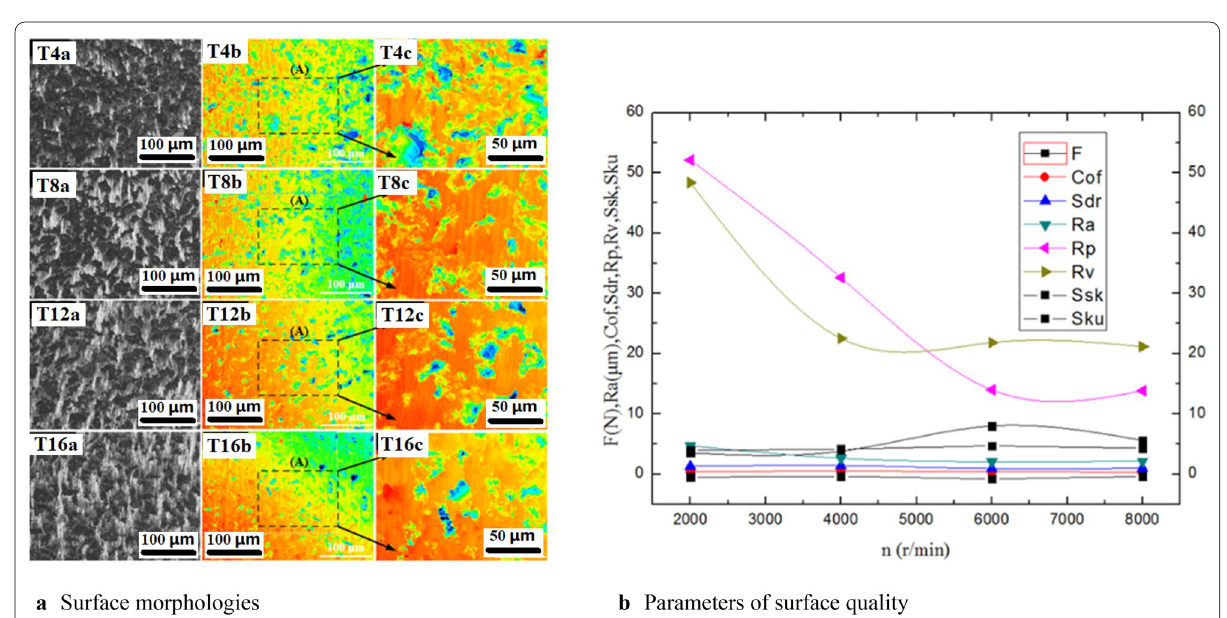
Figure 6 Experimental results of group